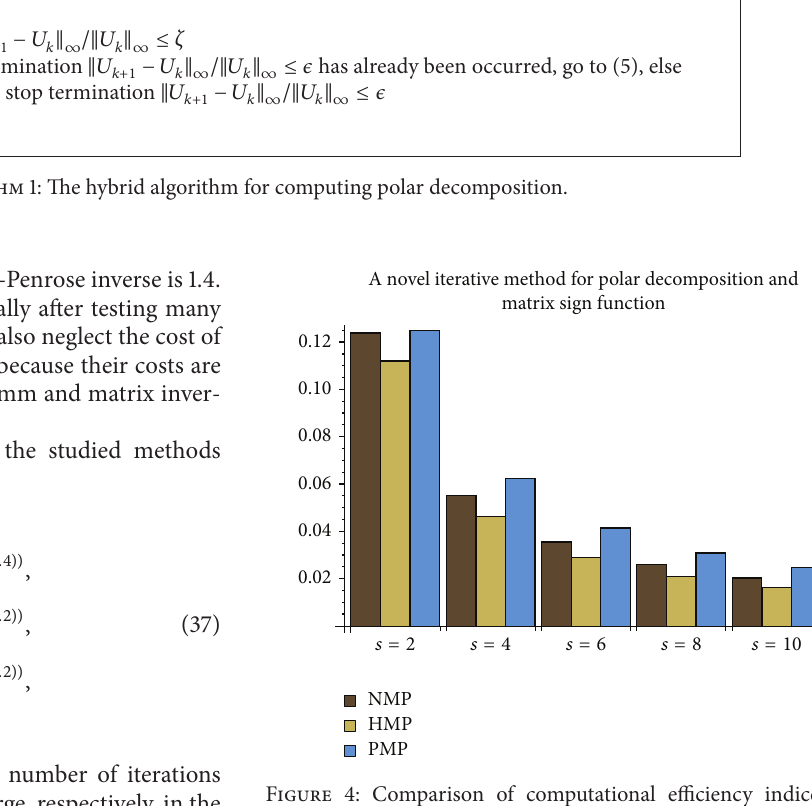
Figure 4: Comparison of computational efficiency indices for different matrix methods in finding the unitary polar